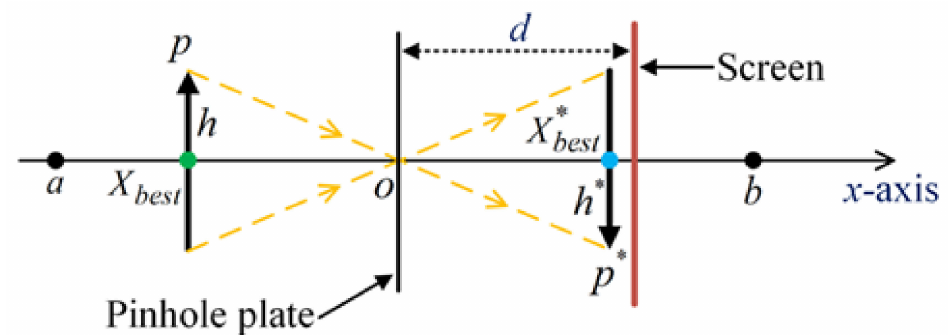
Figure 3. Principle of pinhole imaging opposition-based